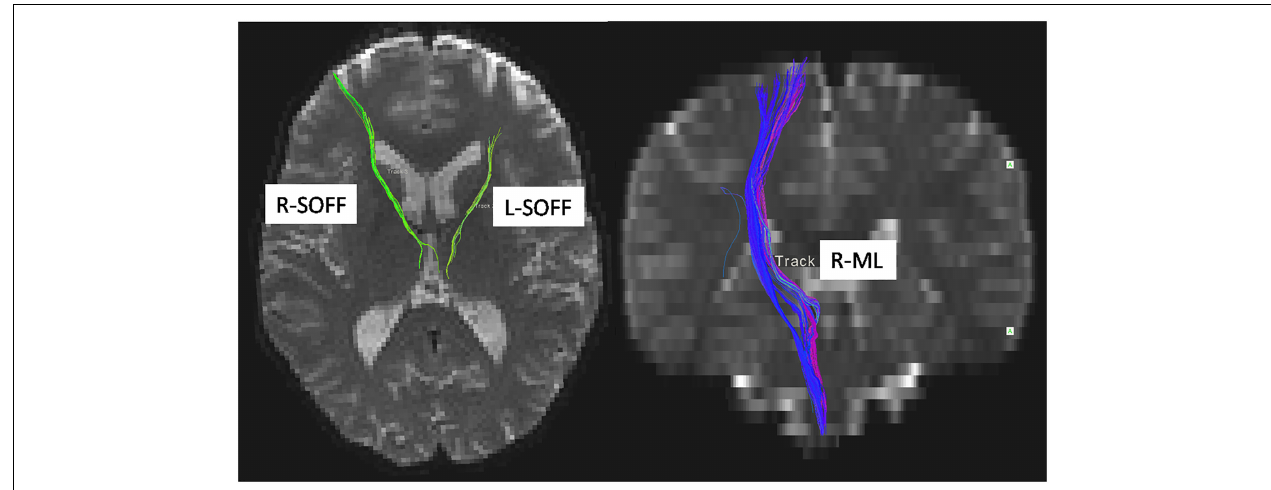
FIGURE 2 | Difference of white matter microstructure between LBC and non-LBC. Tracts with significantly increased mean fractional anisotropy (FA) in the left and right superior occipitofrontal fasciculi (labeled by green color) and decreased FA in right medial lemniscus (labeled by blue color) in LBC relative to parentally raised children. Age and gender were used as covariates. L, left; R, right; ML, medial lemniscus; SOFF, superior occipitofrontal